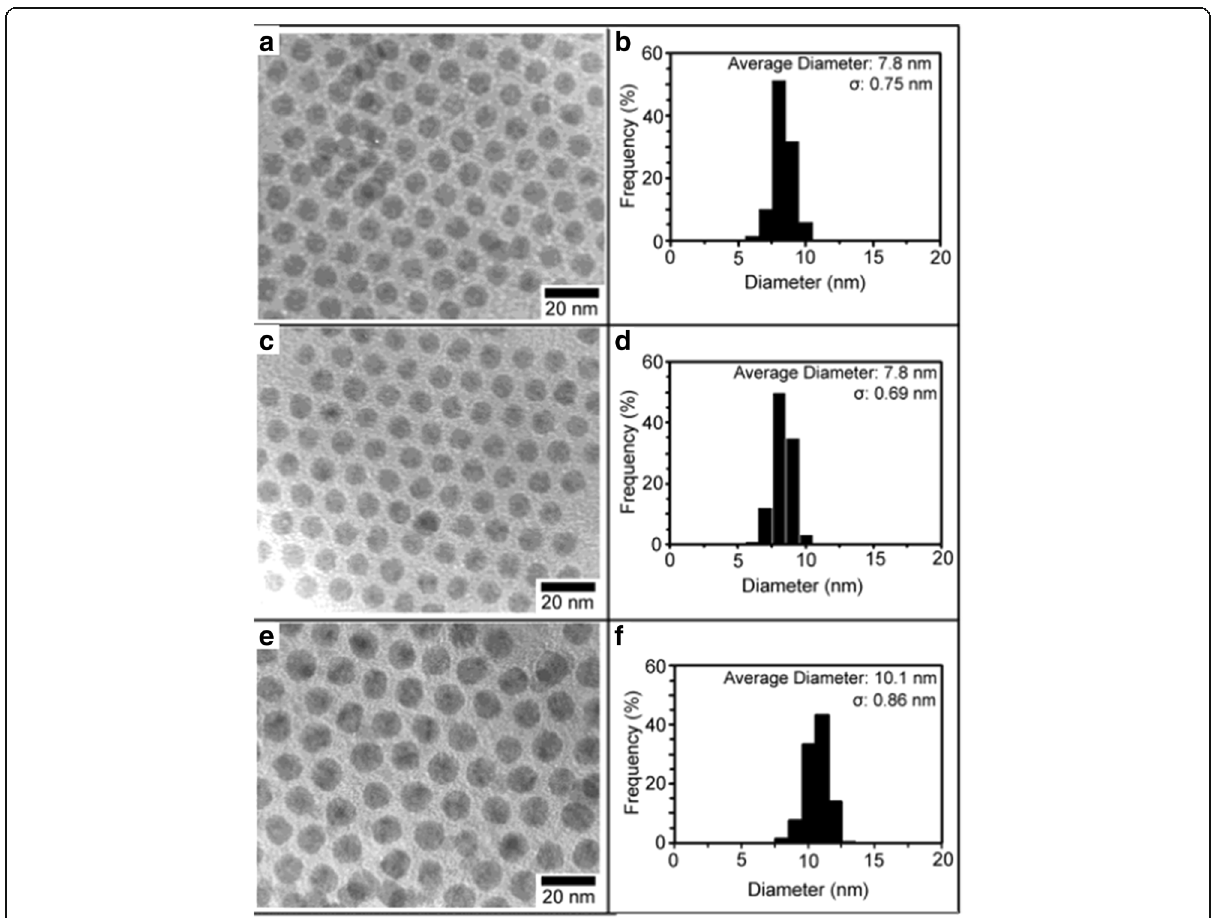
Fig. 6 Bright field TEM images and the corresponding particle size distribution analyses of AgNPs obtained at an oleic acid/silver trifluoroacetate molar ratio of 10:1 for durations of ( a , b ) 30, ( c , d ) 90, and ( e , f ) 150 min